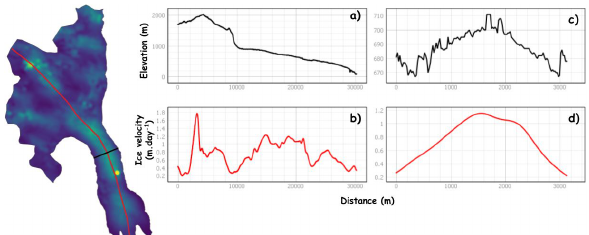
Figure 10. Grey Profile plots of (a) elevation at the top-down longitudinal section; (b) ice velocity at the top-down longitudinal section; (c) elevation at the left-right cross section; (d) ice velocity at the left-right cross